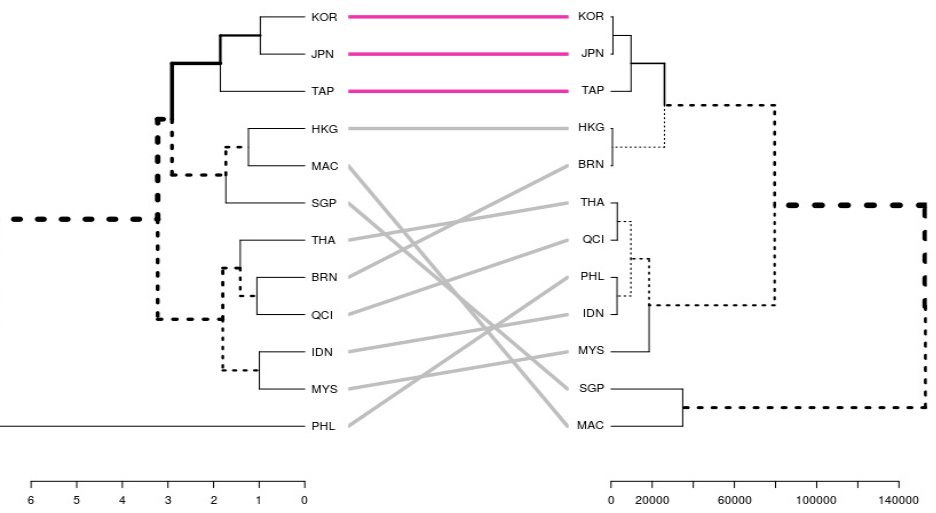
Figure 2. Tanglegram of the dendrograms of the PISA data set ( left ) and socio-economic data set ( right ).